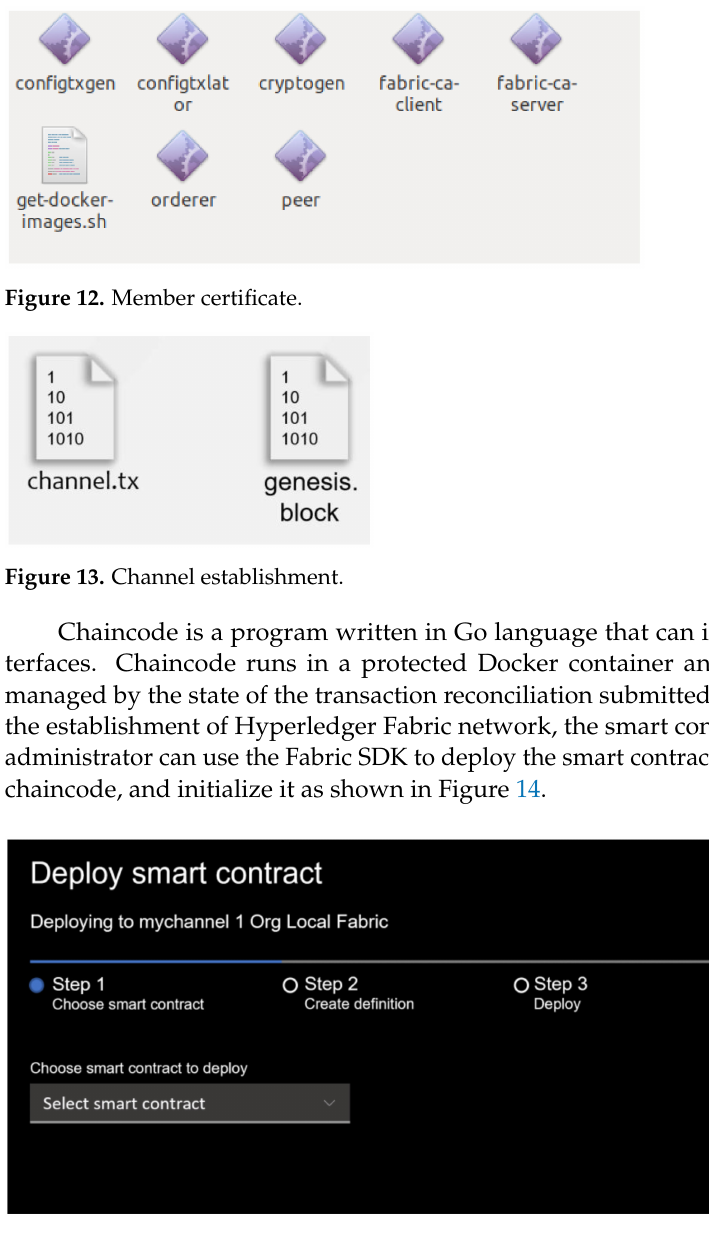
Figure 14. Deploy smart